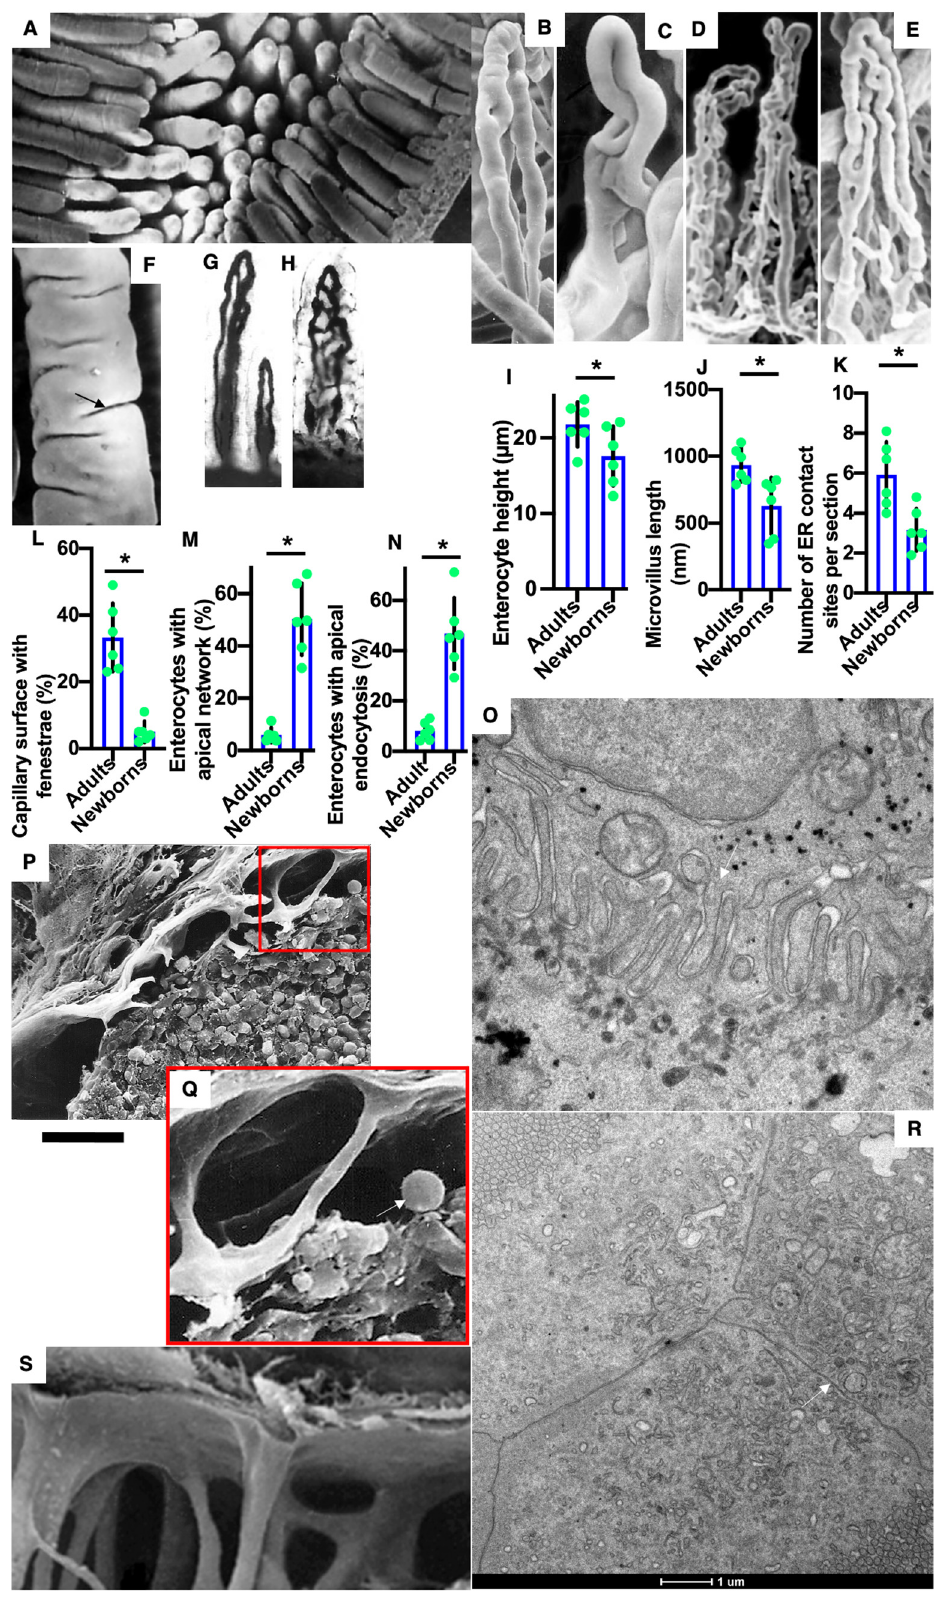
Figure 1. Structure of enterocytes, vascular beds and lymph nodes in newborn rats before their feed- ing. ( A , F ) Scanning electron microscopy of the luminal surface of intestinal villi. (B – H ) The structure of the vascular bed of the intestinal villi of newborn rats before their feeding. ( B – E ) Corrosion casts of blood microvessels in intestinal villus of newborn rats. ( G , H ) Total preparations of intestinal villi